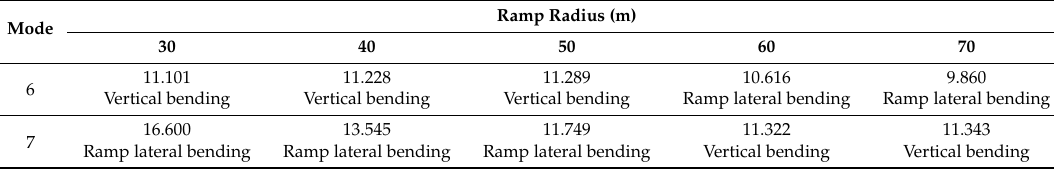
Table 3. Modal frequencies and vibration shapes of the sixth and seventh modes with different ramp radii (Hz).